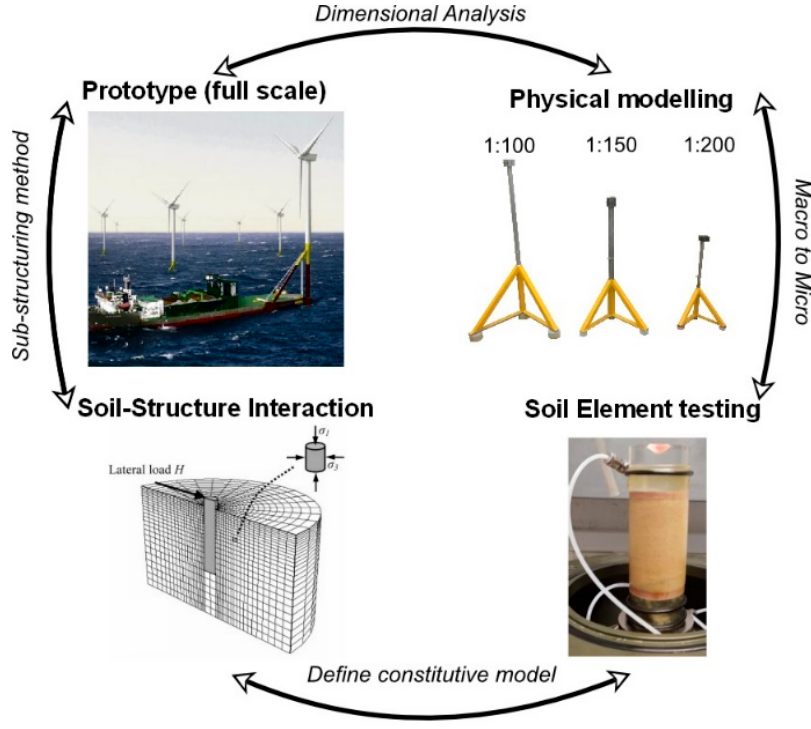
Figure 35. Physical modelling framework for the analysis of foundations.